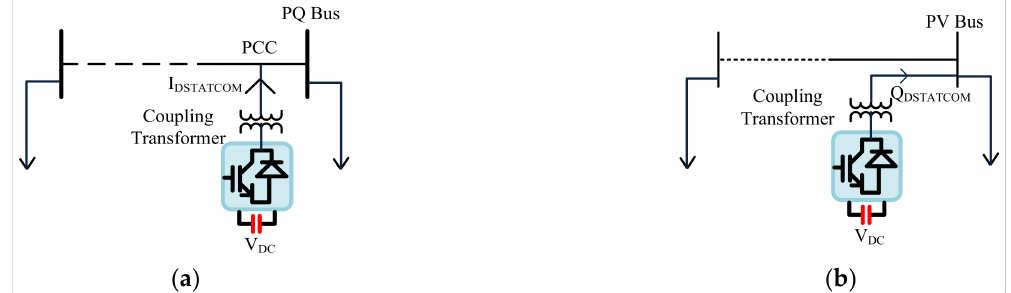
Figure 1. Schematic representation of D-STATCOM modeled as ( a ) PQ Bus and ( b ) PV Bus.